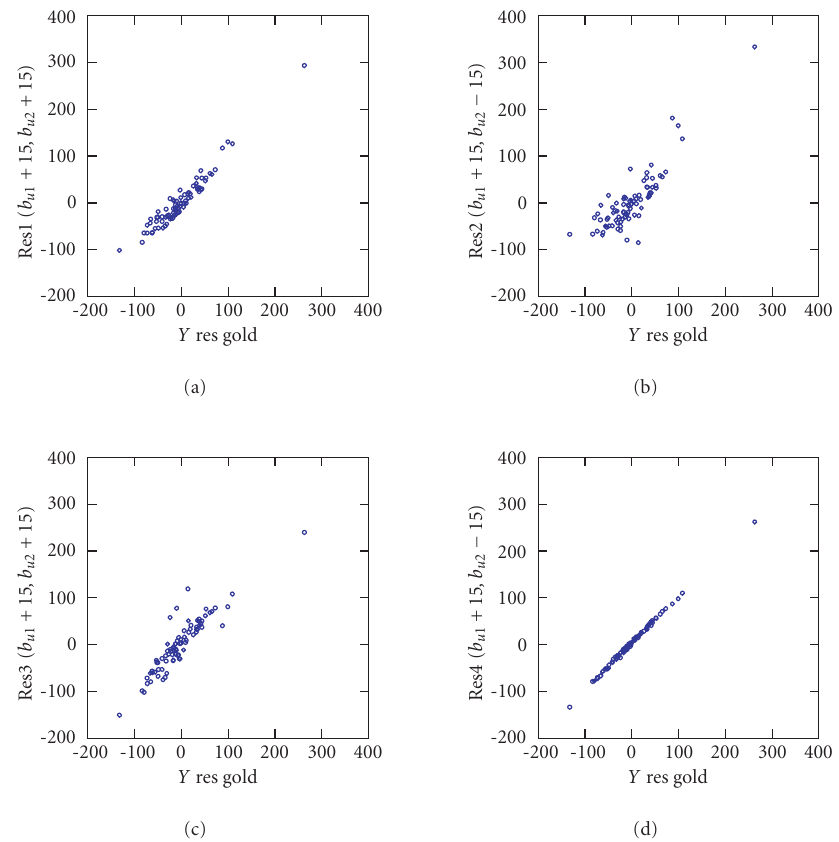
Figure 5. Univariable synthesis method—e ff ect of perturbing both b u 1 and b u 2 on residuals of the perturbed and unperturbed models. The x -axes represent the residuals of the unperturbed model ( Y res gold); the y -axes represent the residuals of the perturbed models. The y -axes labels indicate the perturbation. For example, for RES1, both b u 1 and b u 2 were perturbed by adding 15. The estimating equation was then computed and Y 1 residual was